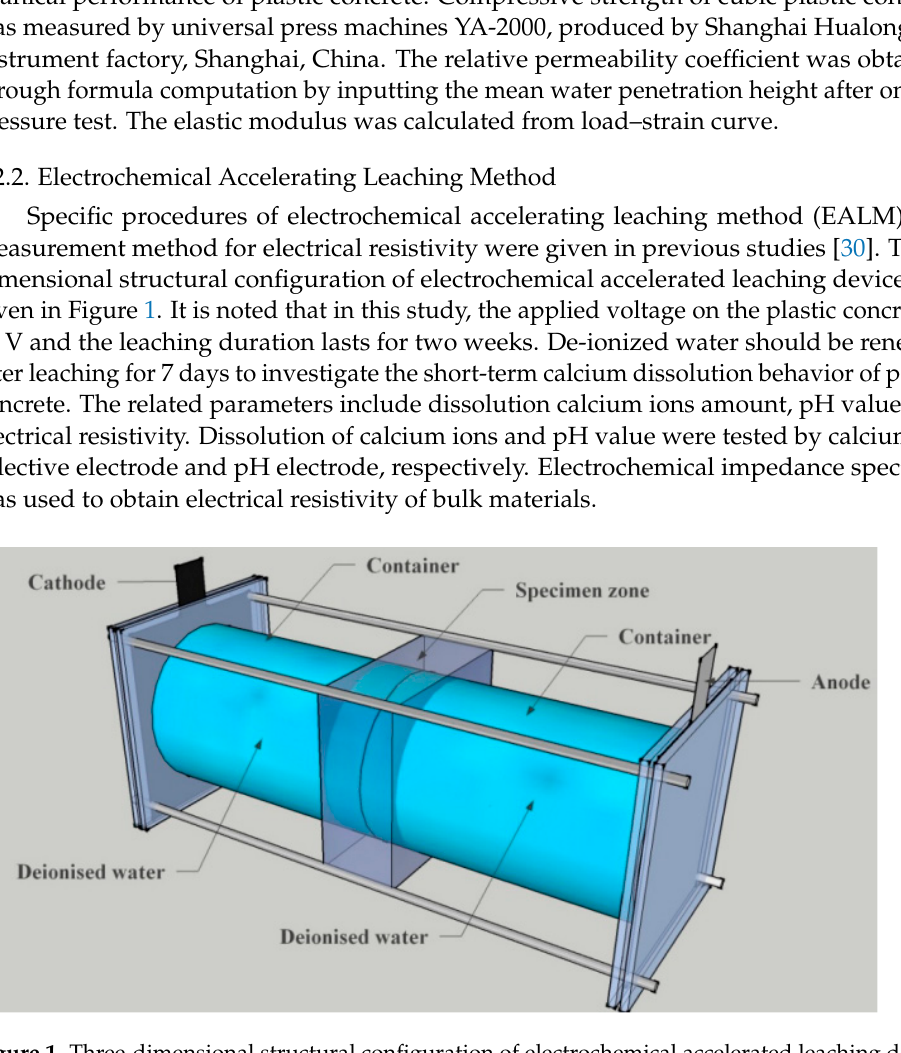
Figure 1. Three-dimensional structural configuration of electrochemical accelerated leaching device. Calcium ion selective electrode and reference electrode form a circuit loop. If the potential of solution was measured, then the corresponding concentration can be